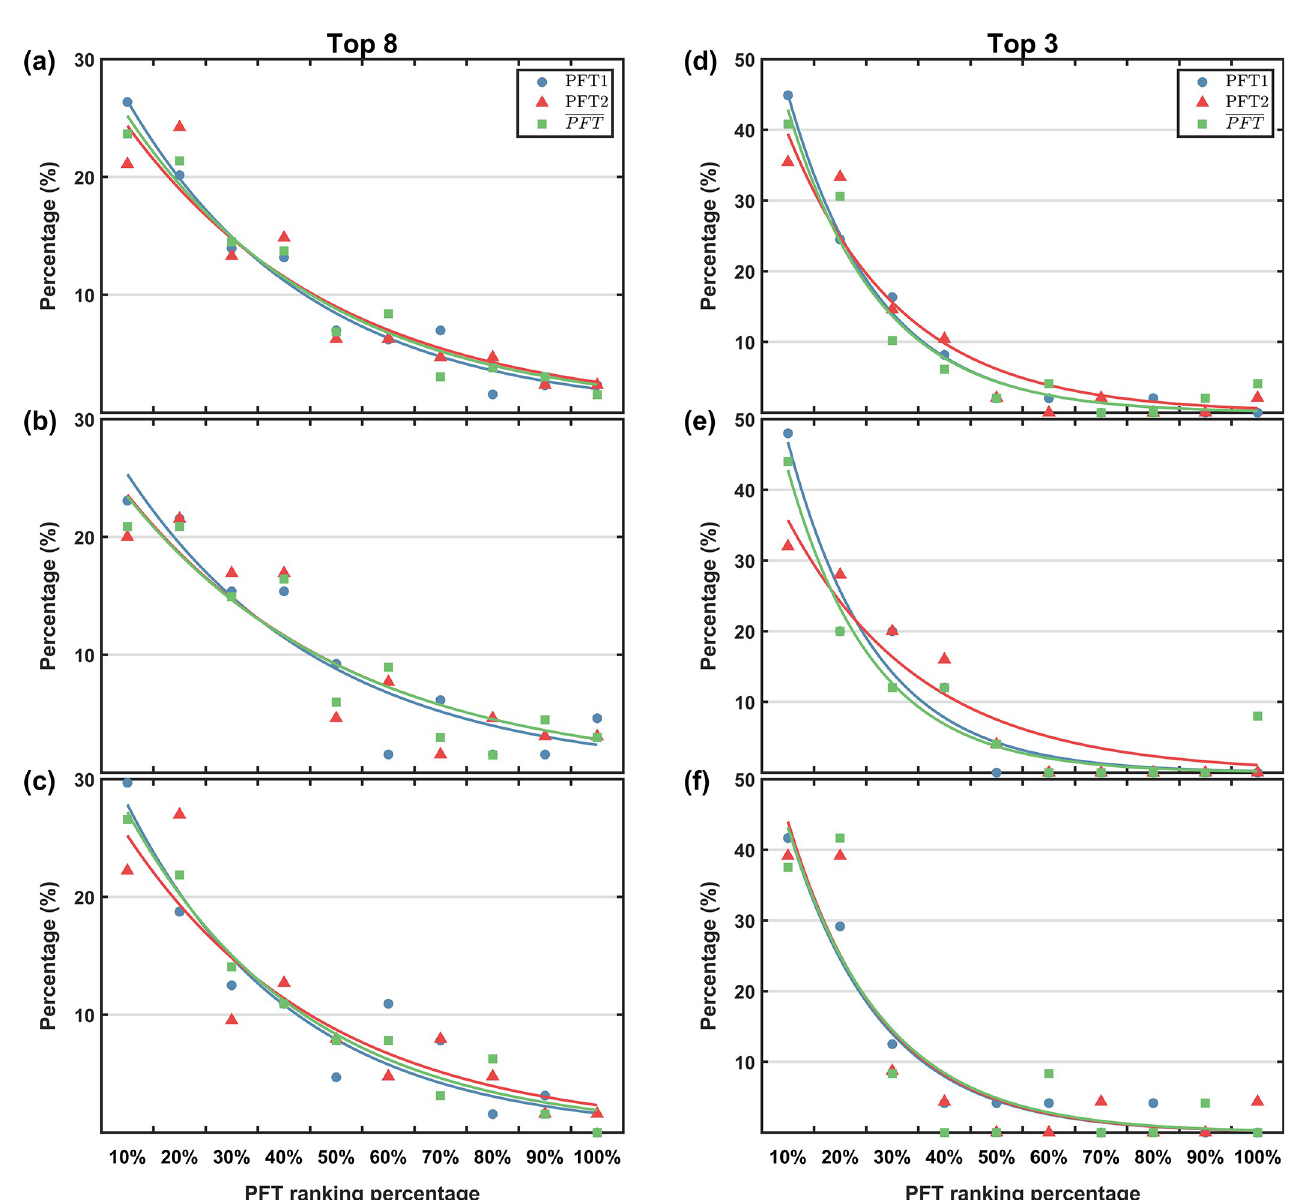
Fig 1. Relationship between total points and physical test scores. The percentage of all athletes (top row), female athletes (middle row) and male athletes (bottom row) in each PFT ranking segment among the top 8 (a-c) and top 3 (d-f) athletes in the final total points. The blue, red and green solid lines correspond to the fitting curves of PFT1, PFT2 and � PFT � ,